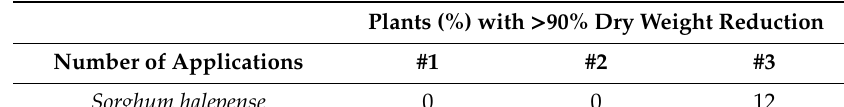
Figure 1. The impact of sequential flaming applications on the dry weight (% of control) of Sorghum halepense ( A ), Cyperus rotundus ( B ) and Ecballium elaterium ( C ). Di ff erent letters indicate significant Table 4. Plants (%) with >90% dry weight reduction following one, two or three applications of di ff erences, as determined by Tukey LSD test ( p ≤ 0.05). Values are means ± SD ( n = 7). flaming ( n = 7). Table 4. Plants (%) with > 90% dry weight reduction following one, two or three applications of flaming ( n =